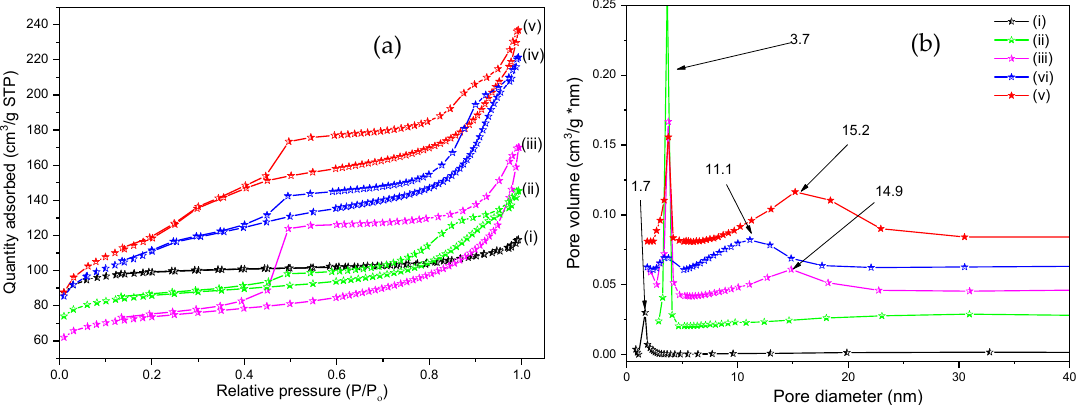
Figure 3. ( a ) N 2 adsorption ‐ desorption isotherm and ( b ) average pore size distribution. (i) ZSM ‐ 5, (ii) ZSM ‐ 5 ‐ T, (iii) ZSM ‐ 5 ‐ Na, (iv) ZSM ‐ 5 ‐ CT, and (v) ZSM ‐ 5 ‐ C.